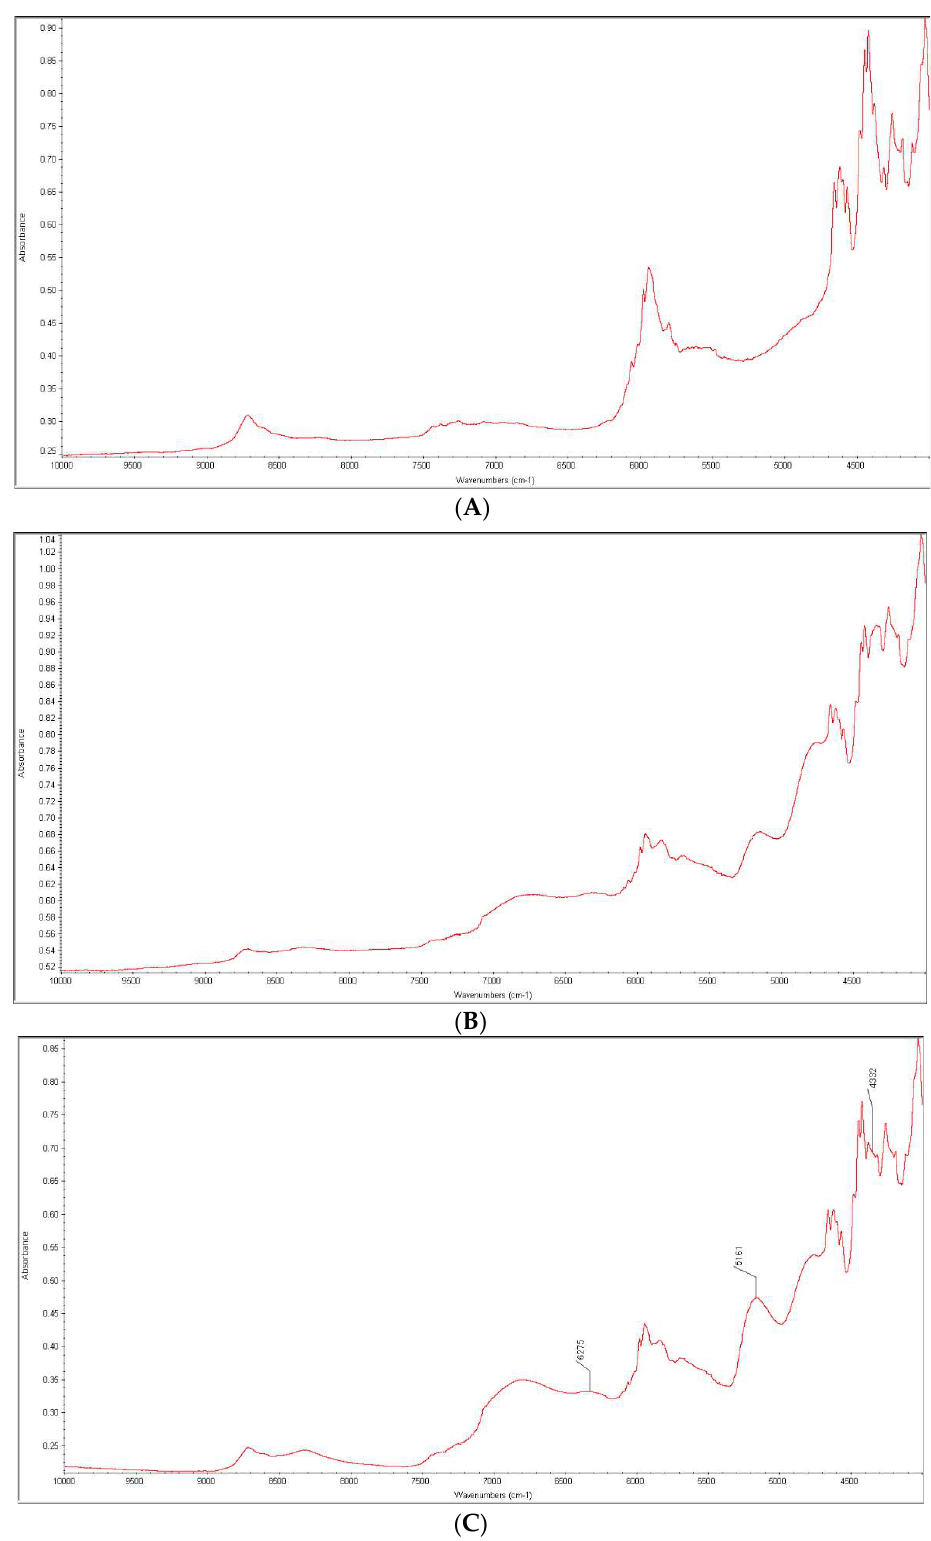
Figure 12. NIR spectra of diphenhydramine (DIPH) as a bulk ( A ) and in the mixtures with polyvinyl alcohol (PVA): non-stressed mixture ( B ) and the mixture stressed under UV/VIS light ( C ).